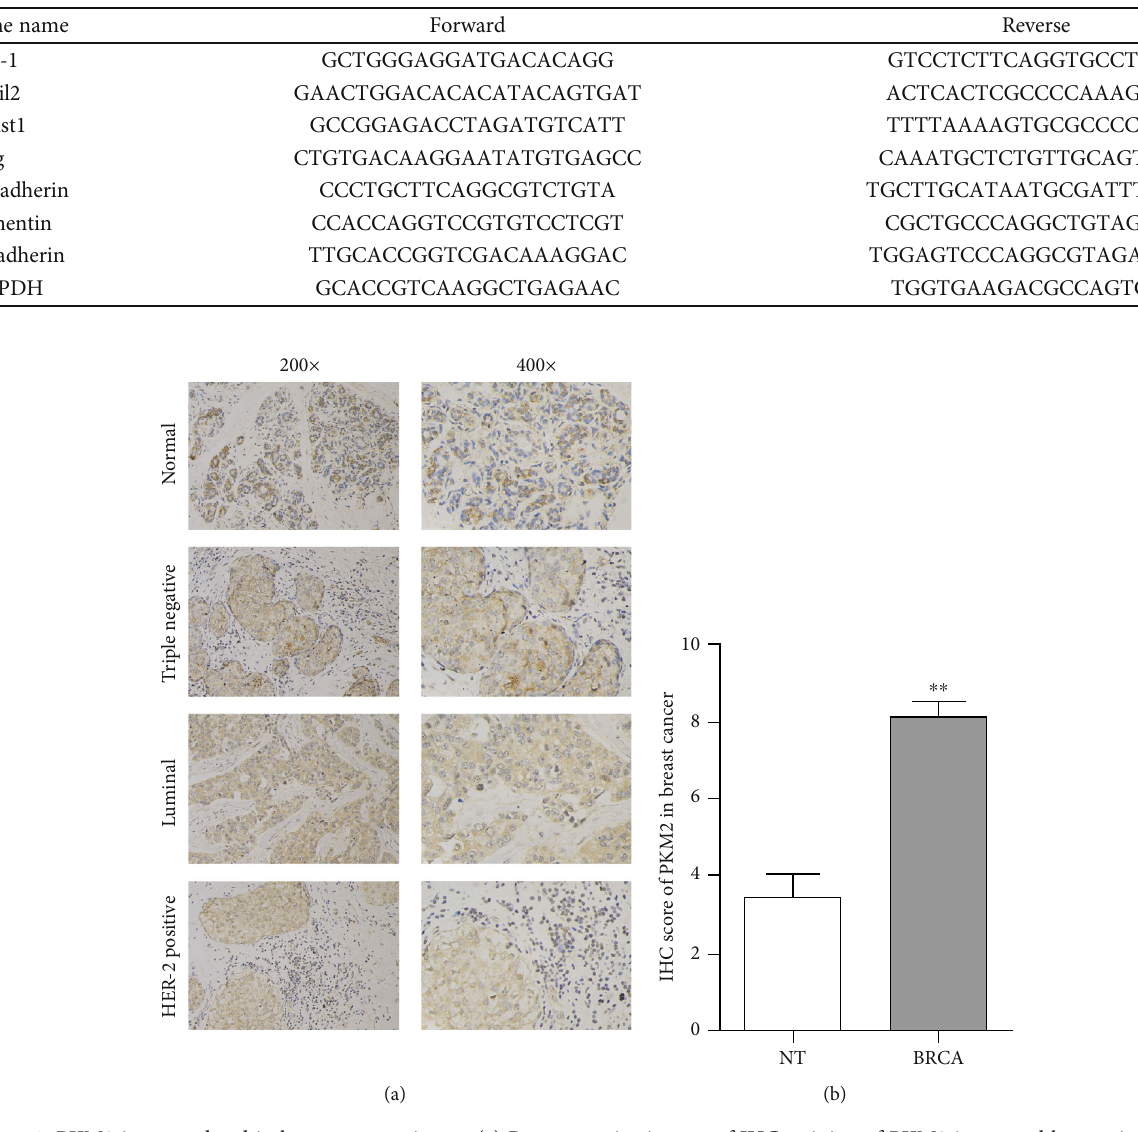
Table 1: Primer sequences for quantitative real-time